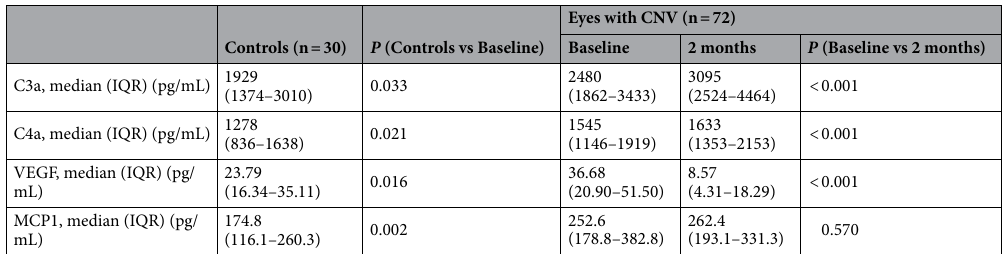
Table 2. Changes in Levels of complement factors and cytokines in the aqueous humor-patients and controls. The data were analyzed using the Mann–Whitney U-test; the eyes with CNV and controls, and baseline and at 2 months. C3a, complement component 3a; C4a, complement component 4a; VEGF, vascular endothelial growth factor; MCP-1, macrophage chemoattractant protein 1. IQR, interquartile range.